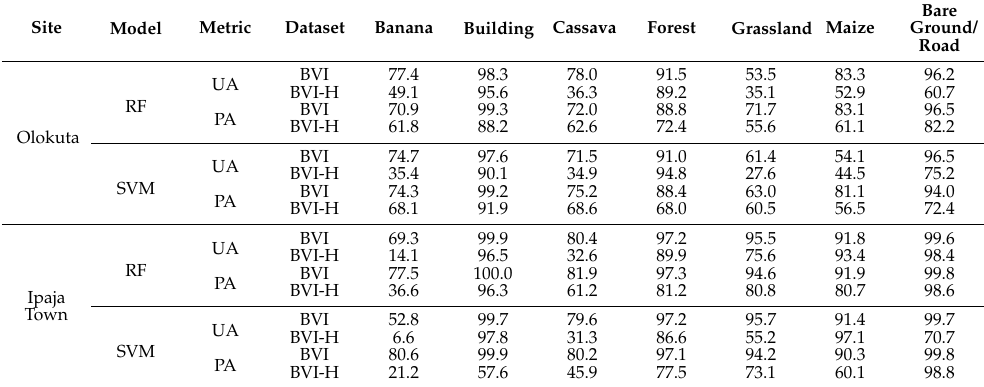
Table 5. UAV user accuracy (UA) and producer accuracy (PA) for Random Forest (RF) and Support Vector Machine (SVM) model